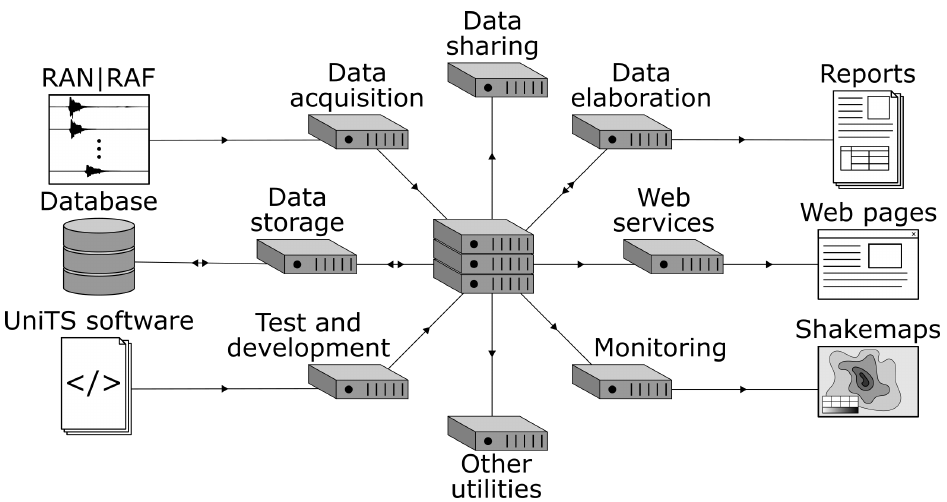
Figure 3. Schema of the RAN Acquisition, Elaboration, Storage, and Data Diffusion Centre (CAED).